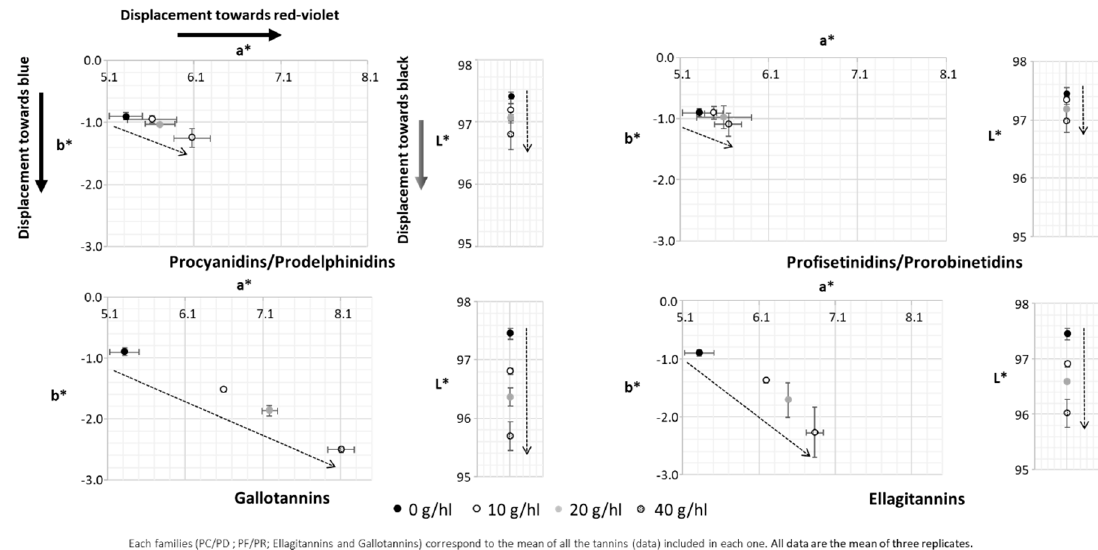
Figure 2. CIELAB color space of model wine solution of malvidin-3- O -glucoside (50 mg / L) supplemented by increasing concentration of ( − )-epicatechin and oenological tannins after one week of experimentation.